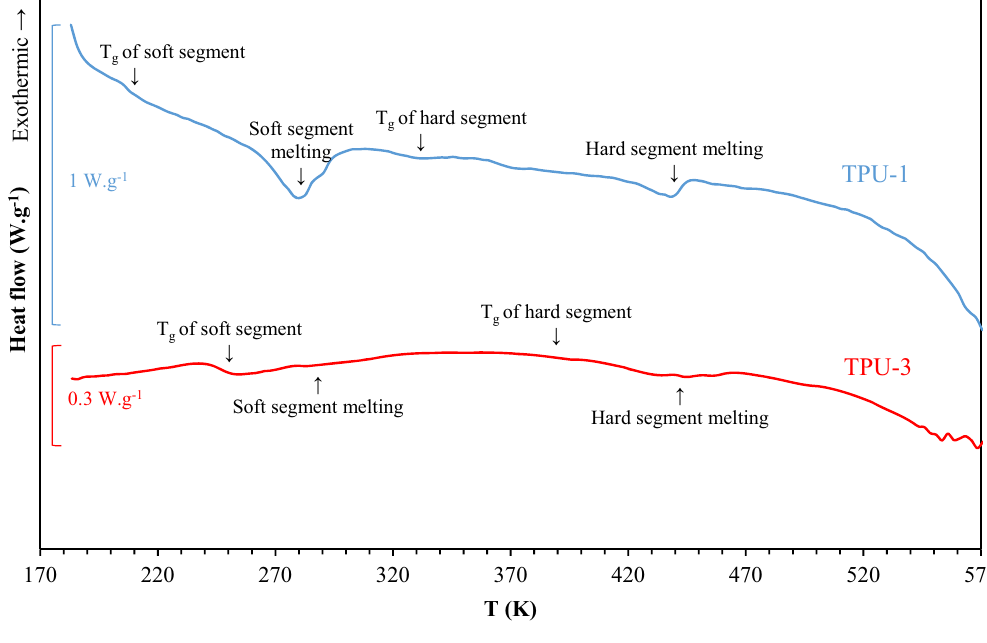
Figure 4. The DSC analysis of the TPU-1 (blue line) and TPU-3 (red line).